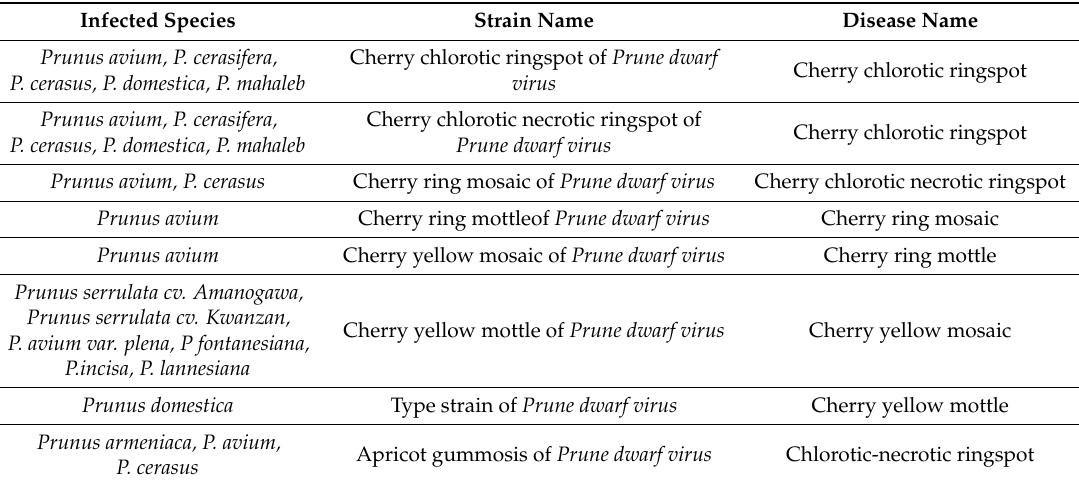
Table 2. Different names of diseases on Prunus species caused by various strains/isolates of PDV according information from Nemeth [17],